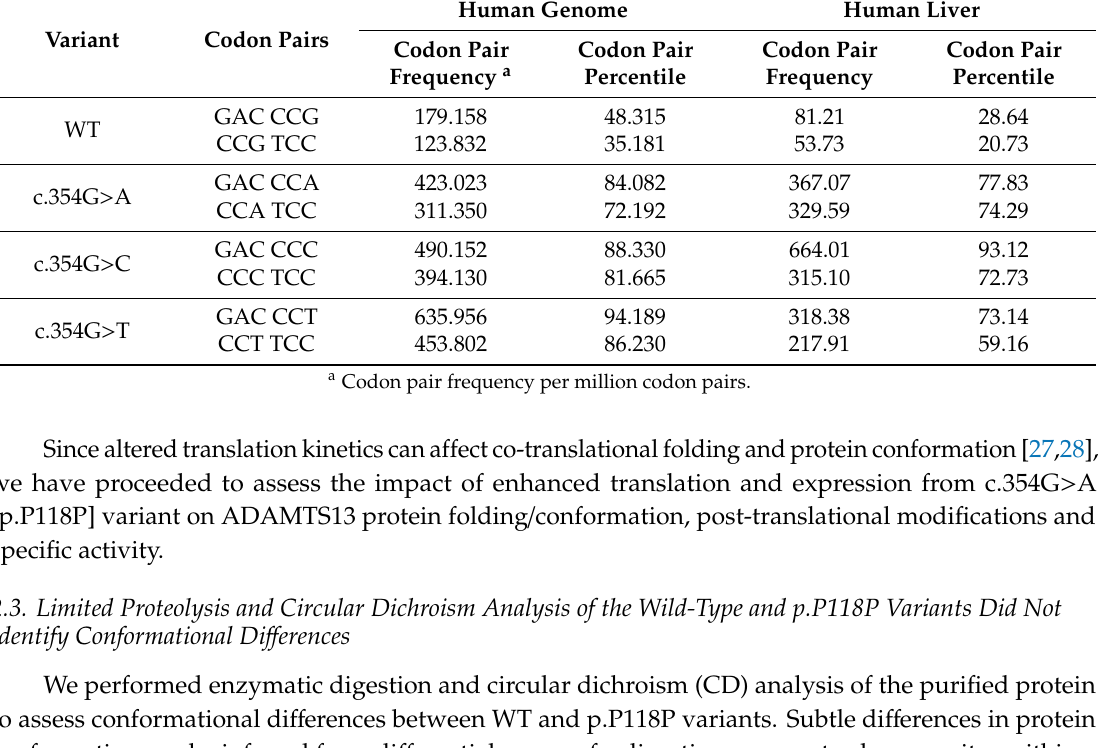
Table 2. Codon pair usage (codon context) of prolineencoding codons in conjunction with preceding (GAC) and subsequent (TCC) codons at P-118 in ADAMTS13 cDNA. Human Genome Human Liver Variant Codon Pairs Codon Pair Codon Pair Codon Pair Codon Pair Frequency a Percentile Frequency Percentile GAC CCG WT CCG